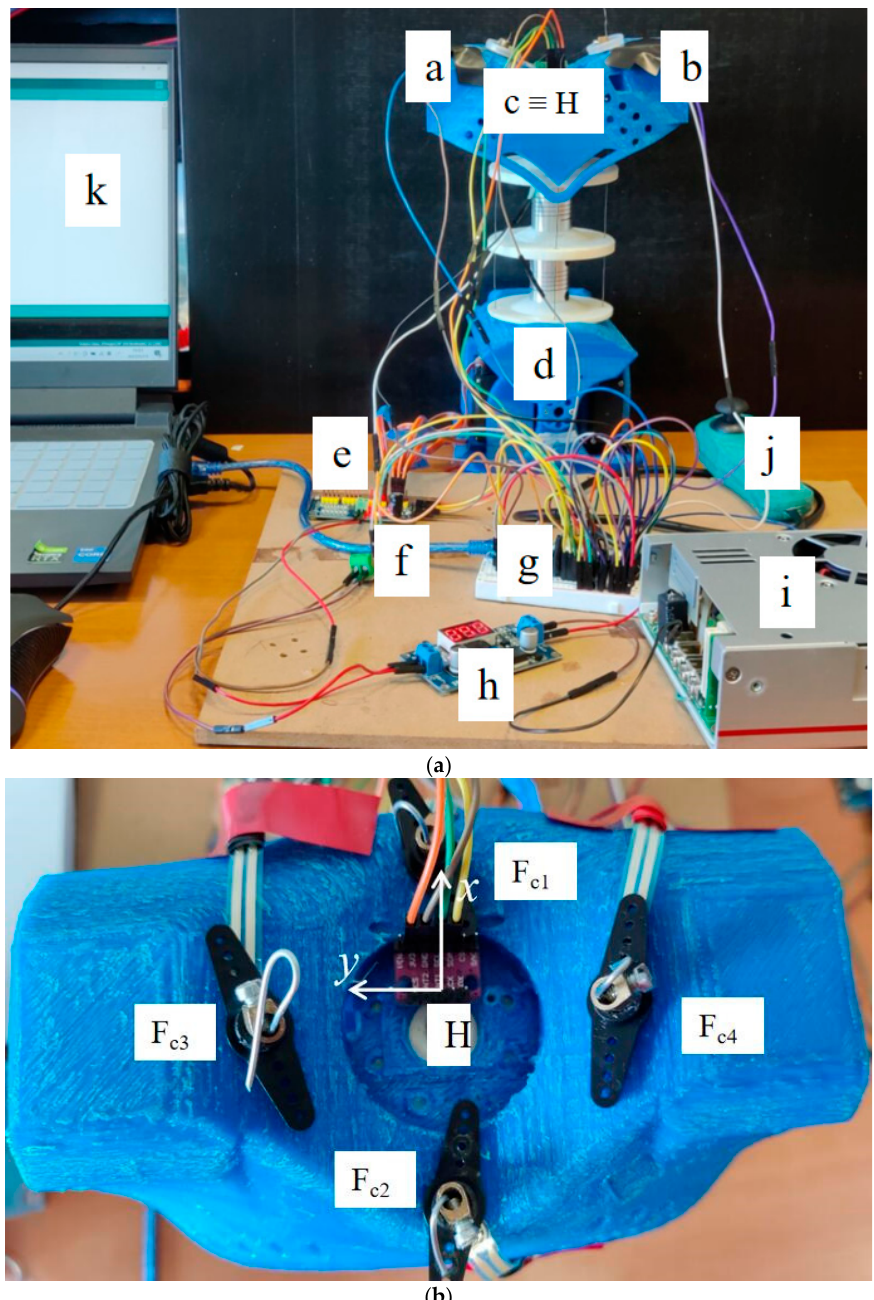
Figure 6. Distribution of sensors in the testing lab setup: ( a ) overall; ( b ) on shoulder body. (a: force sensor F c4 ; b: force sensor F c3 ; c: IMU sensor; d: LARMbot torso V1; e: PCA9685; f: current sensor; g: Arduino nano; h: DC-DC convert; i: power supply; j: joystick; k: laptop). Four force sensors (F c1 & F c2 ; F c3 & F c4 ) are located at suitable positions for measuring the forces between the cables and shoulder. Figure 6b illustrates the distribution of force sensors on the shoulder body. The type of the force sensor is RP-C7.6-LT model, [24], which is flexible ultra-thin, has ultra-low power consumption, extreme speed response, and high stability. The pressure induction range is 20 g ~ 1.5 kg. The activation time is less